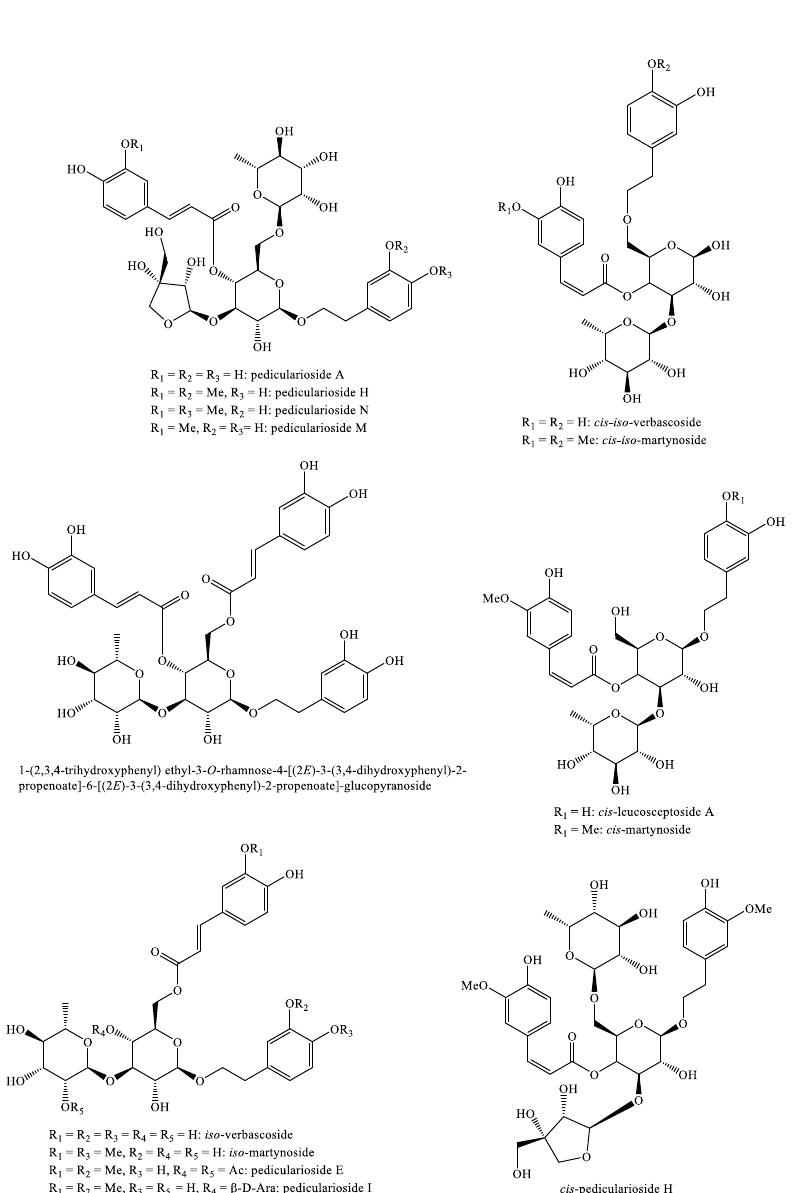
Figure 10. Phenylethanoid glycosides identified in Pedicularis species—part 1.